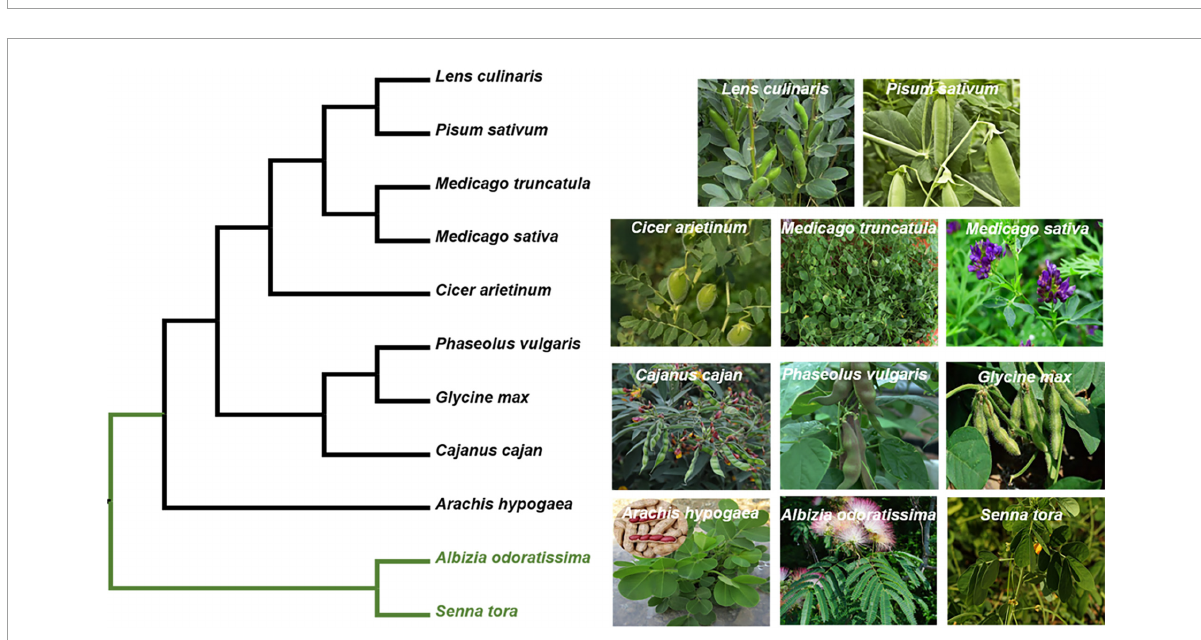
FIGURE4 Phylogeny of M. truncatula with the other legumes. The phylogeny of the targeted species was reconstructed based on their plastomes. The data matrix of Azani et al. (2017) was used as a basic DNA matrix, from which we extract the sequences of the targeted species and outgroups ( Albizia odoratissima and Senna tora ). Then, these sequences were aligned with the complete plastomes of M. truncatula . The maximum likelihood (ML) phylogeny was reconstructed using RAxML version 8.2.12. Their accession number obtained from GenBank. Albizia odoratissima : NC_034987.1; Arachis hypogaea : NC_026676.1; Cajanus cajan : NC_031429.1; Cicer arietinum : NC_011163.1; Glycine max : NC_007942.1; Lens culinaris : NC_027152.1; Medicago sativa : KU321683.1; Medicago truncatula : JX512024.1; Phaseolus vulgaris : NC_009259.1; Pisum sativum